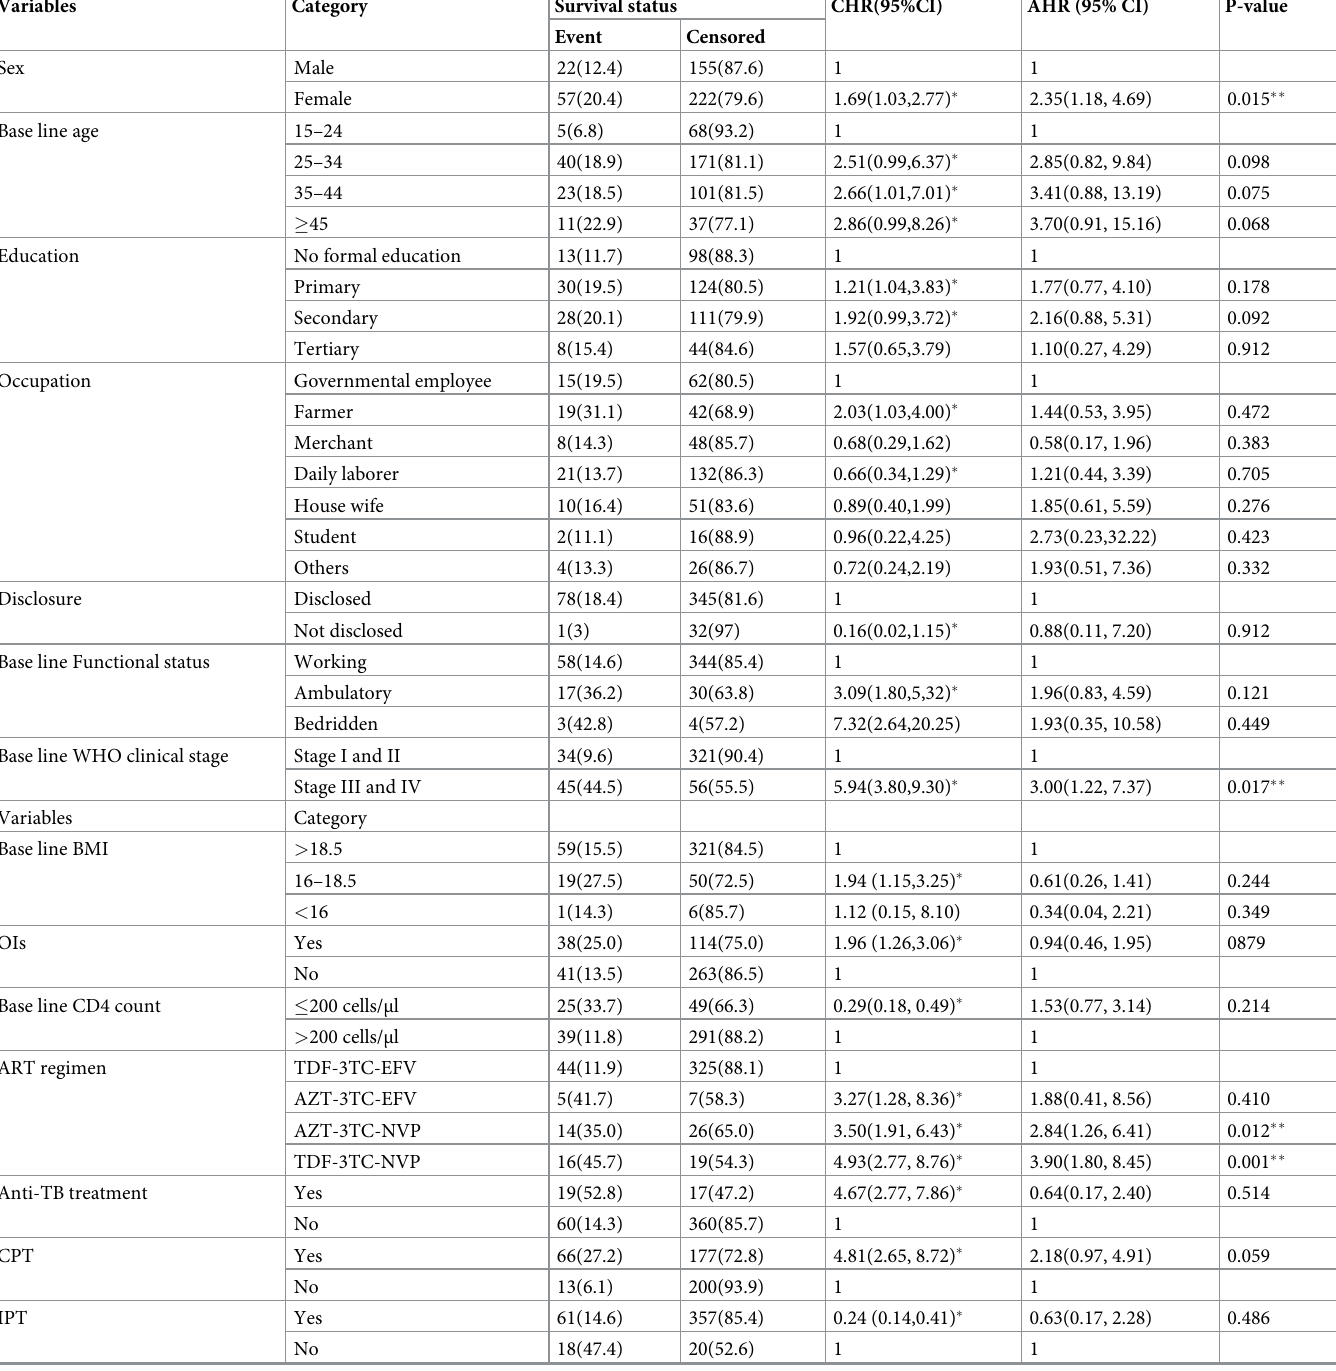
Table 8. Multiple-variable Cox regression for predictors of ADRs among HIV positive adults on ART at Arba Minch town public health facilities, January 2013 to December